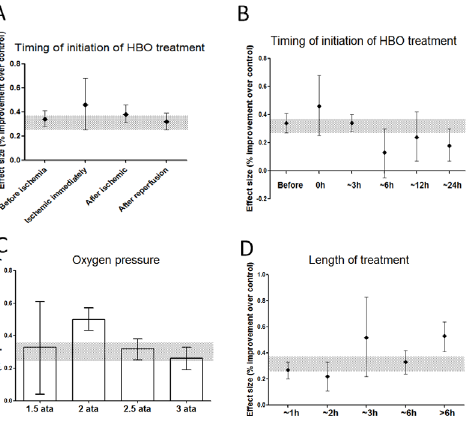
Fig 3. Point estimates and 95% CIs of effect size by: (A,B) Timing of initiation of HBO treatment, (C) Oxygen pressure, (D) Length of treatment. The 95% CI for the global estimate is shown as a grey band.